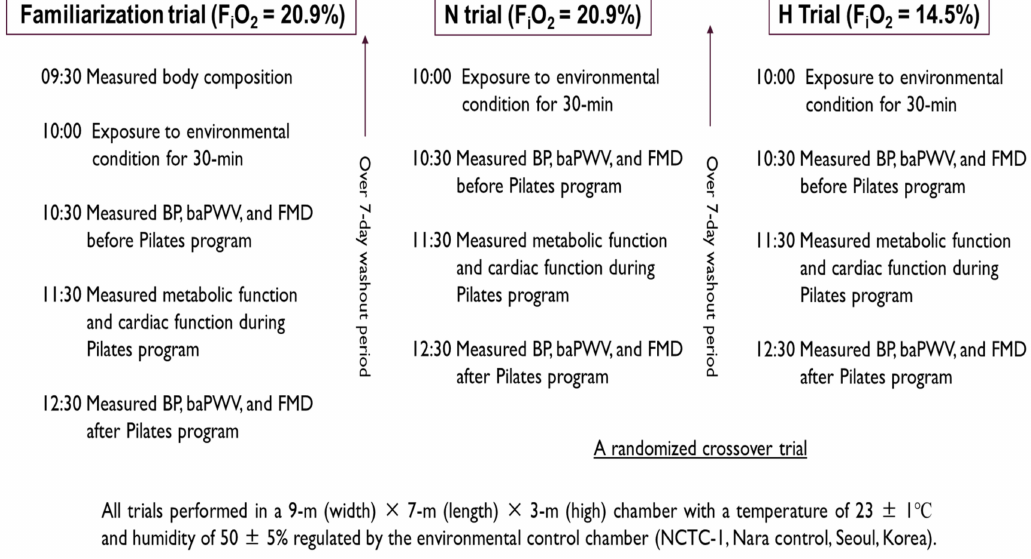
Figure 2. Study design. N trial: Pilates program under normoxic conditions, H trial: Pilates program under hypoxic conditions, FiO 2 : inspired oxygen fraction, BP: blood pressure, baPWV: branchial ankle pulse wave velocity, and FMD: flow-mediated